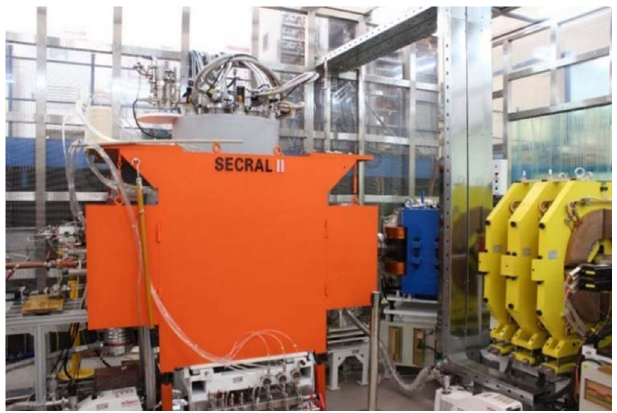
FIG. 32. The SECRAL-II ECR ion source at beam